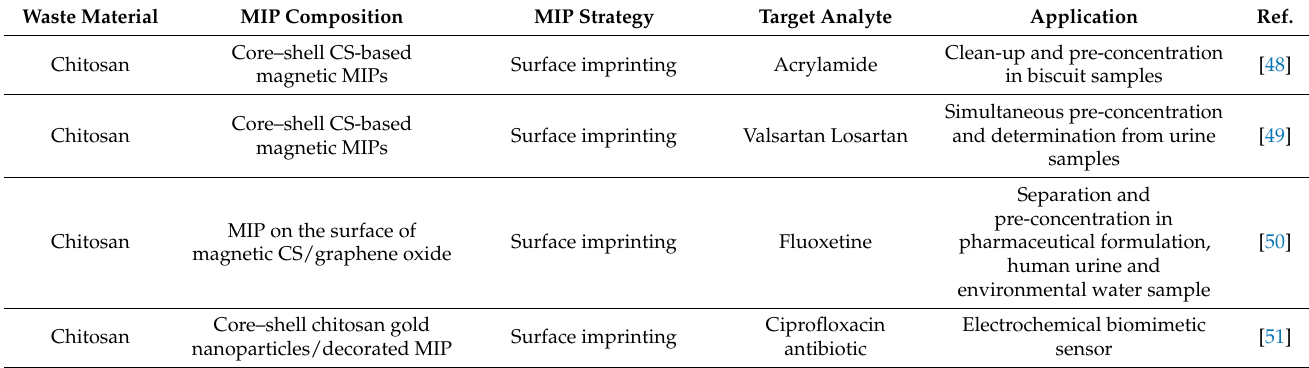
Table 1. An overview of the reported studies on the use of various waste sources in MIPs preparation. Waste